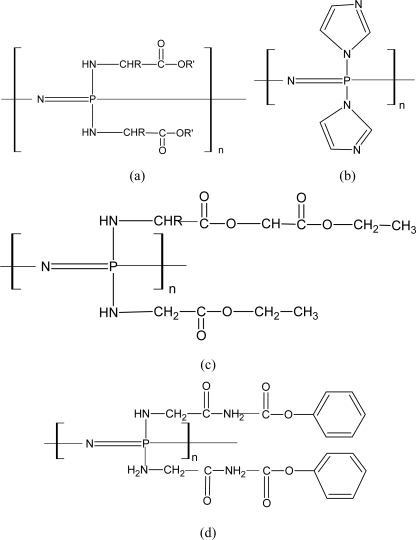
Structures of biodegradable aminated polyphosphazenes [74].